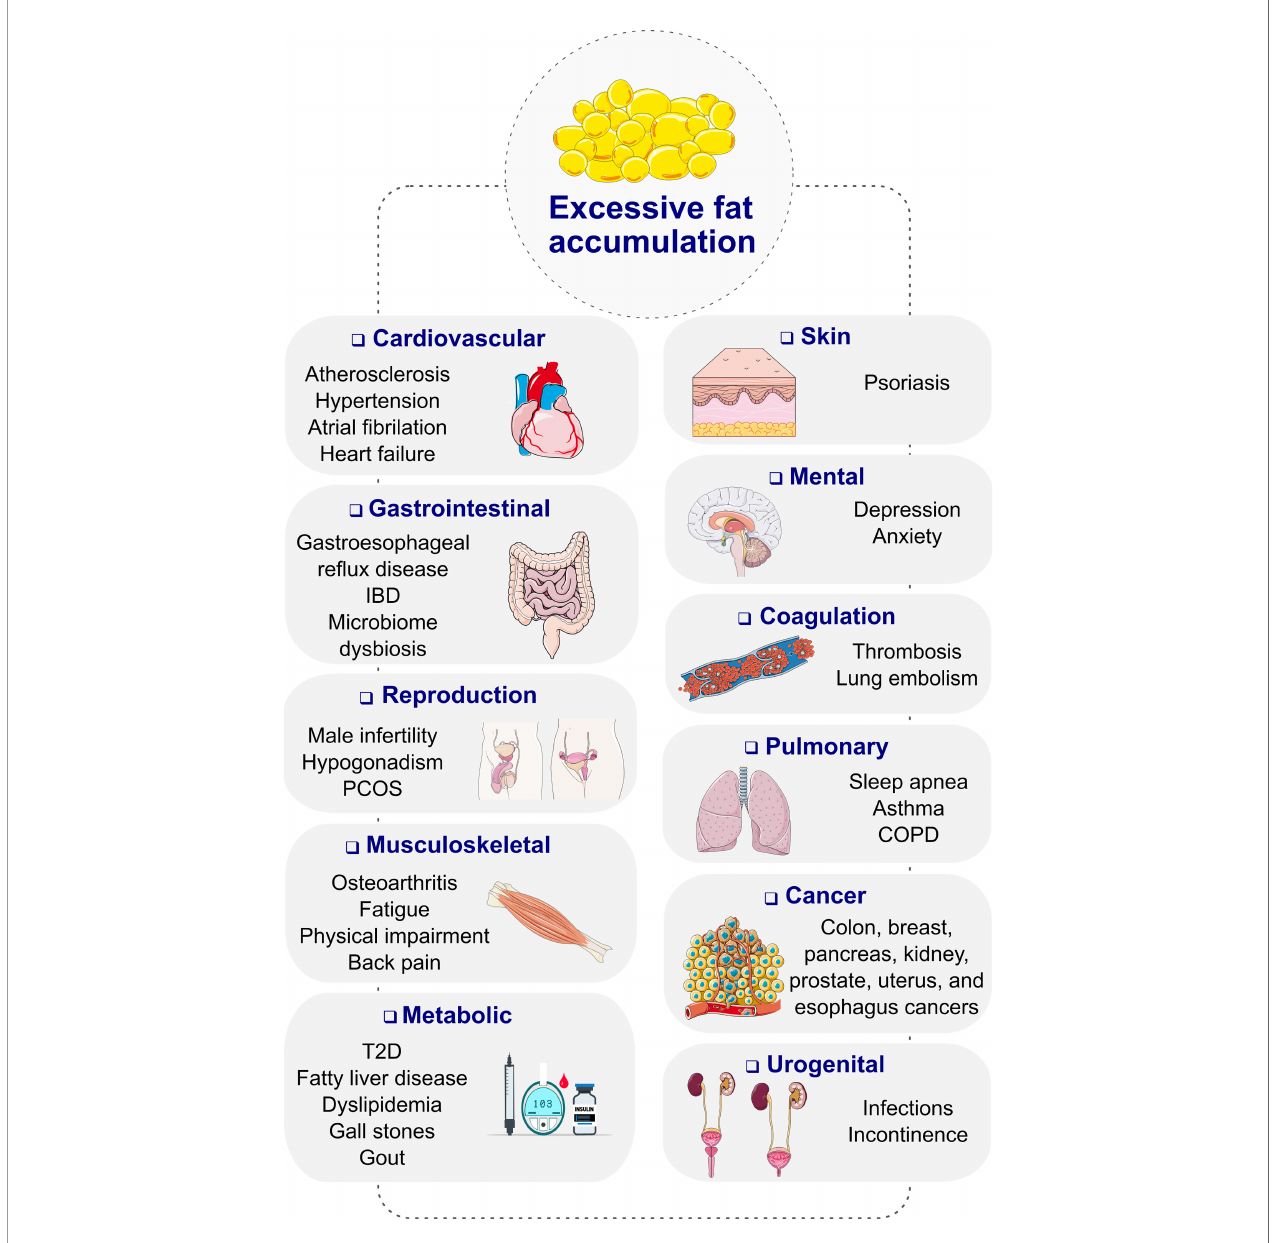
FIGURE 1 | Complications of obesity. COPD, chronic obstructive pulmonary disease; IBD, in fl ammatory bowel disease; PCOS, polycystic ovary syndrome; T2D, type 2 diabetes. Images retrieved from